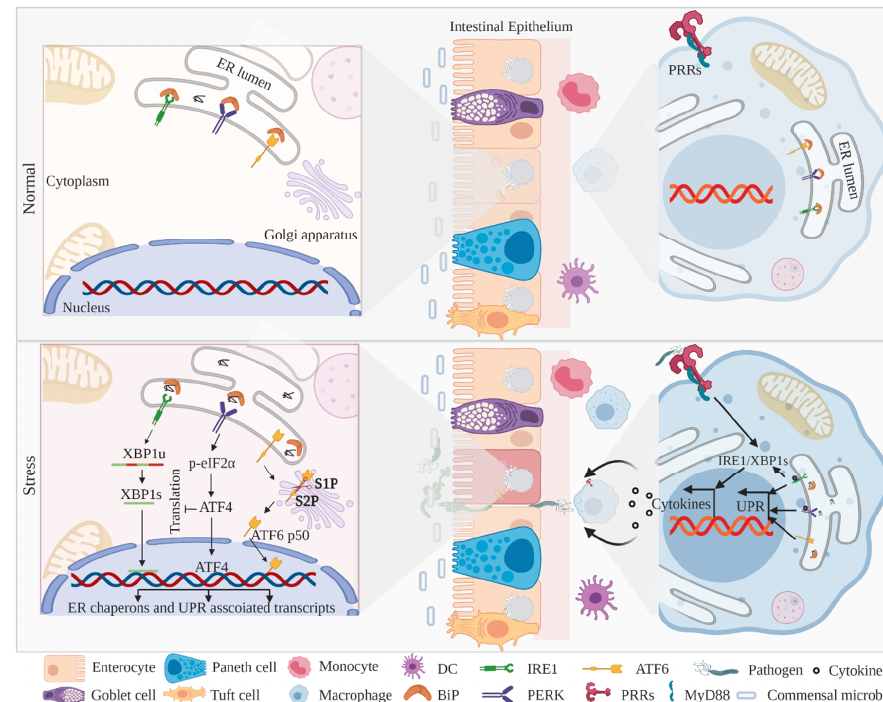
Figure 1. Endoplasmic reticulum (ER)-associated unfolded protein response (UPR) signaling in intestinal epithelial cells (IECs) and myeloid cells. The three branches of ER-UPR, IRE1a, PERK, and ATF6, remain inactive and sequestered with chaperon BiP in the resting stage. Intestinal epithelium perturbation activates all three branches of ER-UPR and leads to sequential activation of downstream target gene-encoding chaperons and transcriptional regulators to restore ER homeostasis. Similarly, the macrophages (right), upon encountering pathogenic intrusion, activate PRRs and coordinate with UPR signaling to induce proinflammatory cytokines and UPR-associated transcripts to protect against microbial intrusion. DC, dendritic cell; PRRs, pathogen recognition receptors; S1 / 2P, site 1 / 2 proteases; UPR, unfolded protein response; XBP1u / s, XBP1 unspliced /